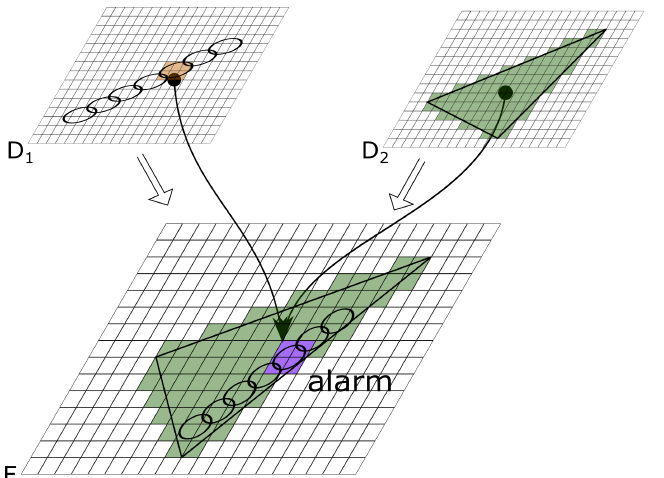
Figure 1. Illustration of fusion approach with two weighted maps. Weight map D 1 for PIR detec- tions ( left ). Weight map D 2 for detections of person classification using thermal camera images ( right ). Resulting alarm of fusion ( bottom